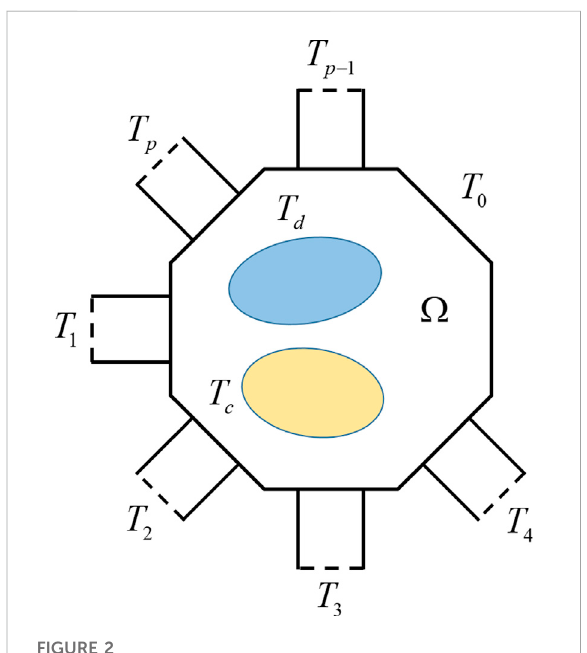
FIGURE 2 Schematic diagram of general circuit